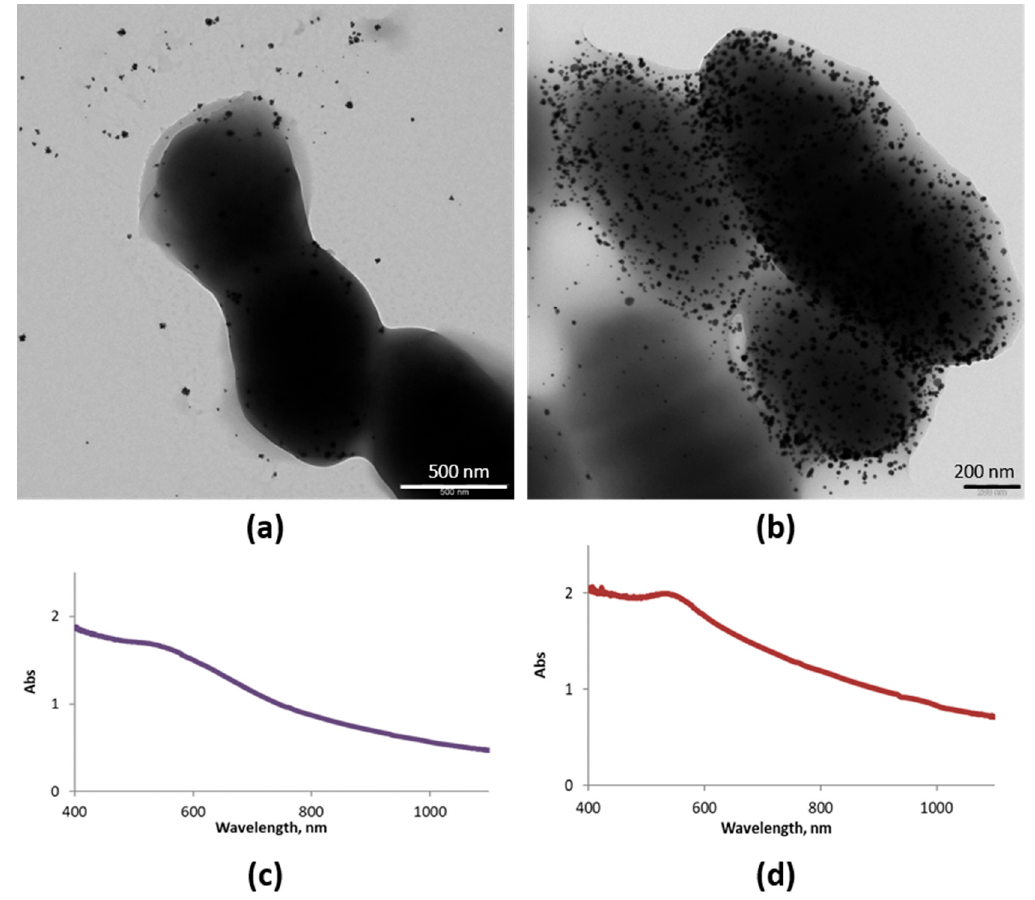
Figure 5. Synthesized AuNPs (SAuNPs)–ferment data obtained by UV-vis and TEM: ( a ) TEM images for SAuNPs–ferment obtained after 2 h ( a ) and 24 h ( b ) of incubation. UV-vis spectra for SAuNPs–ferment obtained after 2 h ( c ) and 24 h ( d ) of incubation.